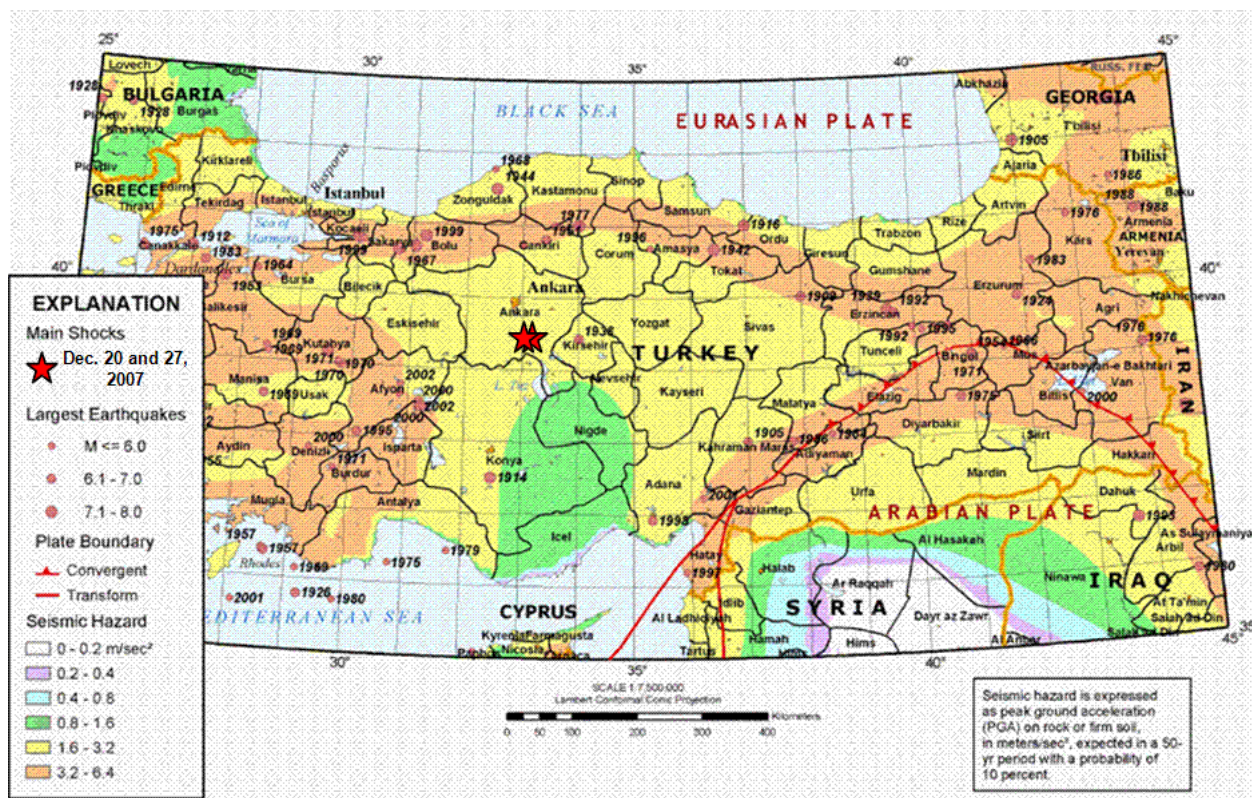
Fig. 3. Seismic hazard settings of Turkey (modified from USGS, 2008).